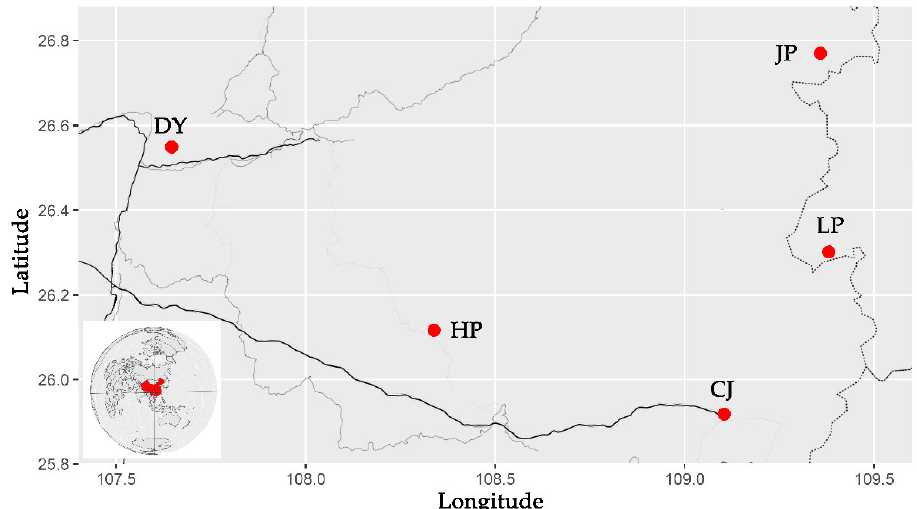
Figure 2. Sampling information diagram (the red circles indicate the sampling points, while uppercase letters indicate the name of the population).